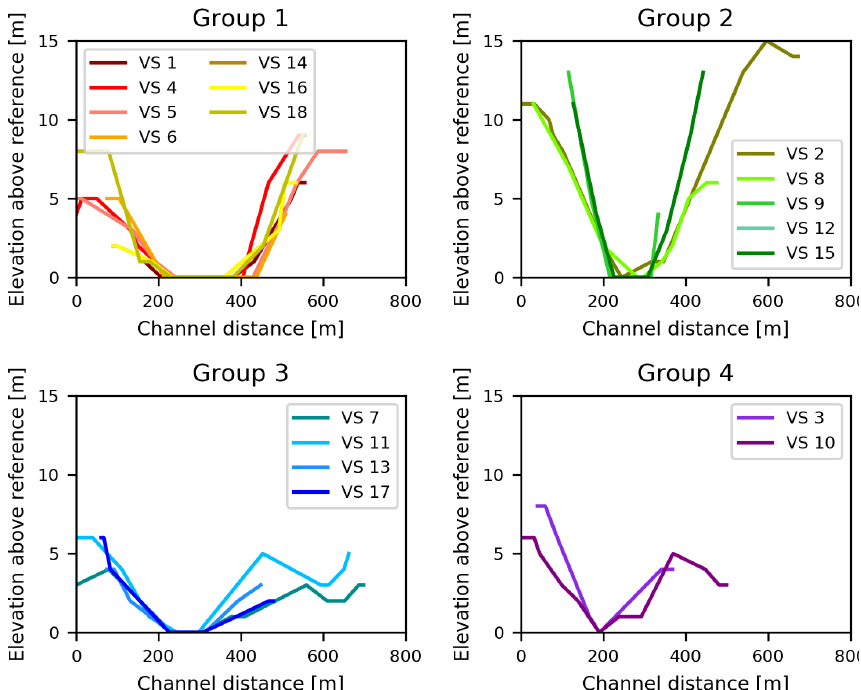
Figure 3. River profiles at 18 virtual stations (VS) divided into four groups. The reference level is equal to the lowest water level in the river profile for each location separately.